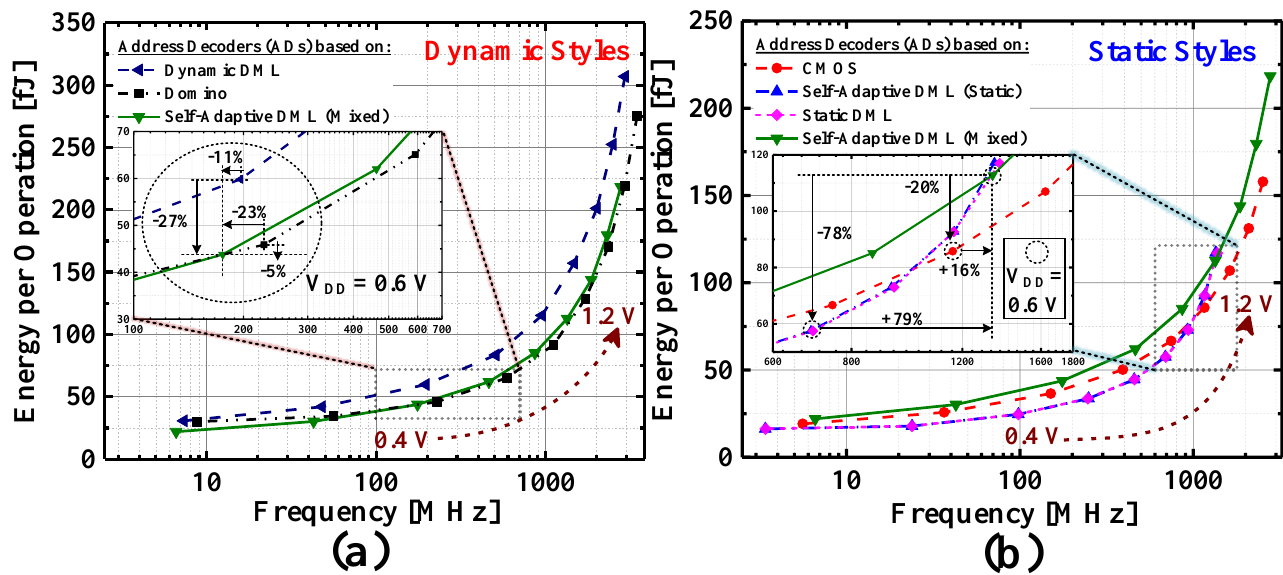
Figure 6. Energy—frequency characteristics for V DD ranging from 0.4 to 1.2 V in steps of 0.1 V. The dynamic families are grouped on ( a ), while the static families are presented on ( b ).